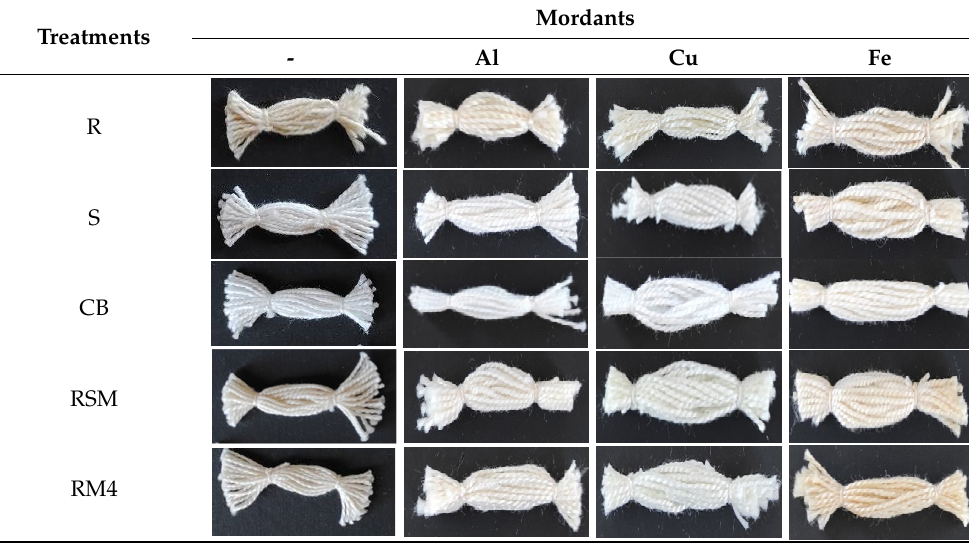
Table 4. Pre-treated and mordanted cotton yarns.